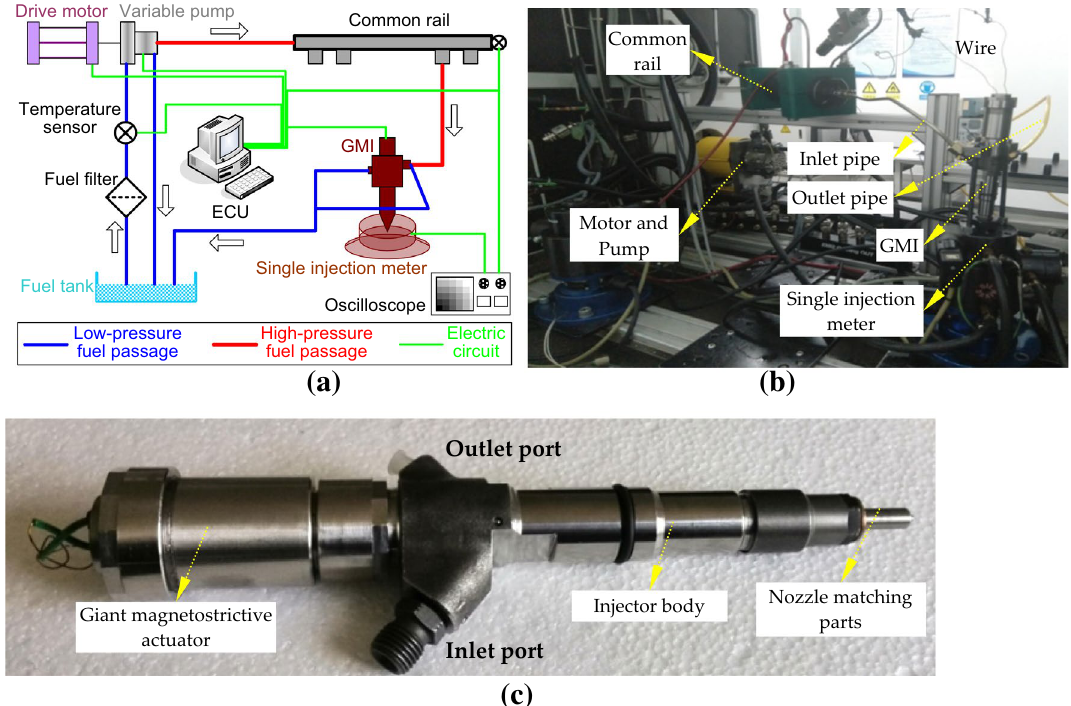
Figure 4. Experimental setup for the GMI: ( a ) schematic diagram of test system; ( b ) instrument hardware diagram; ( c ) GMI